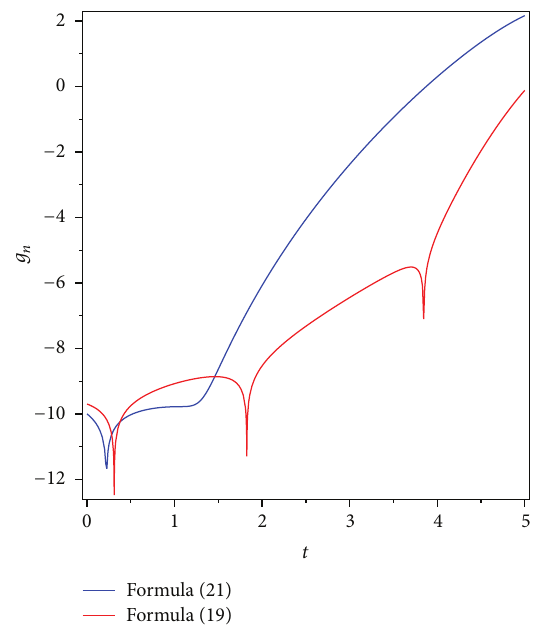
Figure 1: The comparisons of the approximate solutions using (19) and